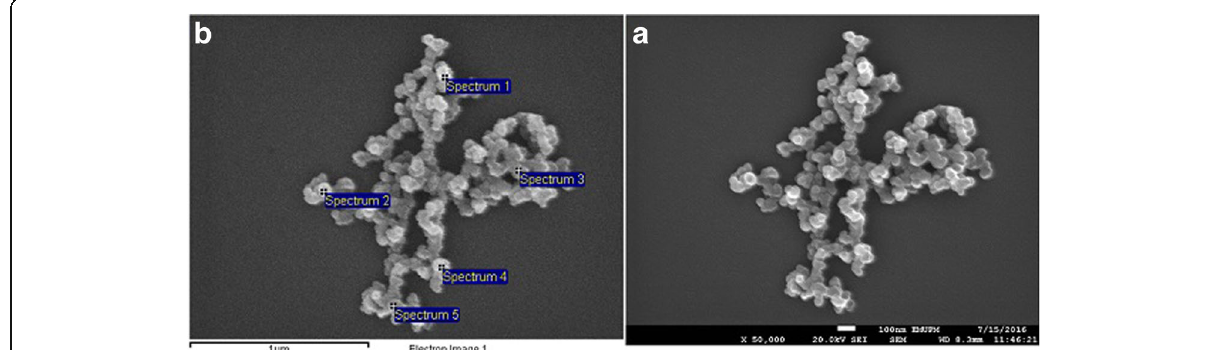
Fig. 2 FESEM a FESEM micrograph of the Au-CSCaCO 3 NPs describing the morphology. b EDX spectra of the Au-CSCaCO 3